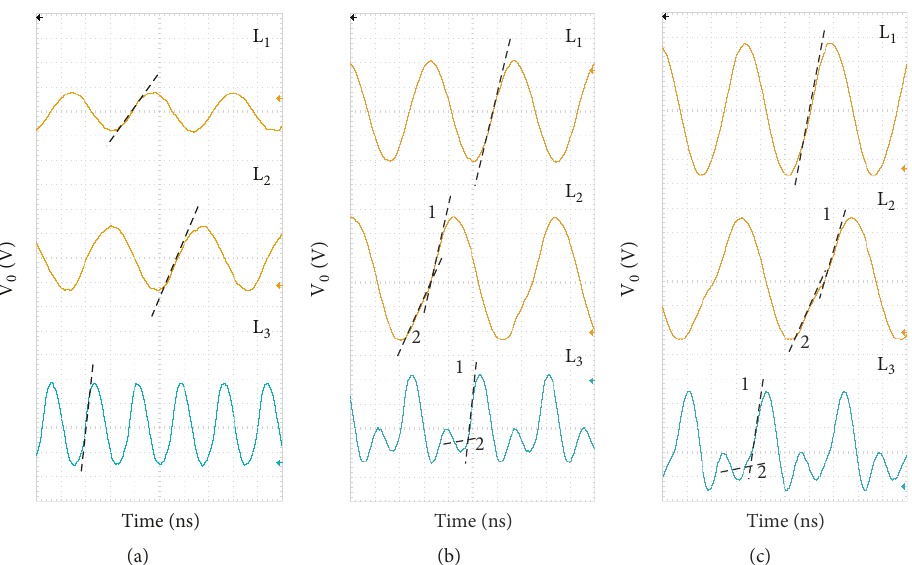
Figure 8: Output voltage waveforms from the proposed circuit of Figure 1(b). (a) Under bias at 𝐼 𝐶 = 30𝑚𝐴 . (b) Under bias at 𝐼 𝐶 = 60𝑚𝐴 . (c) Under bias at 𝐼 𝐶 = 90𝑚𝐴 .